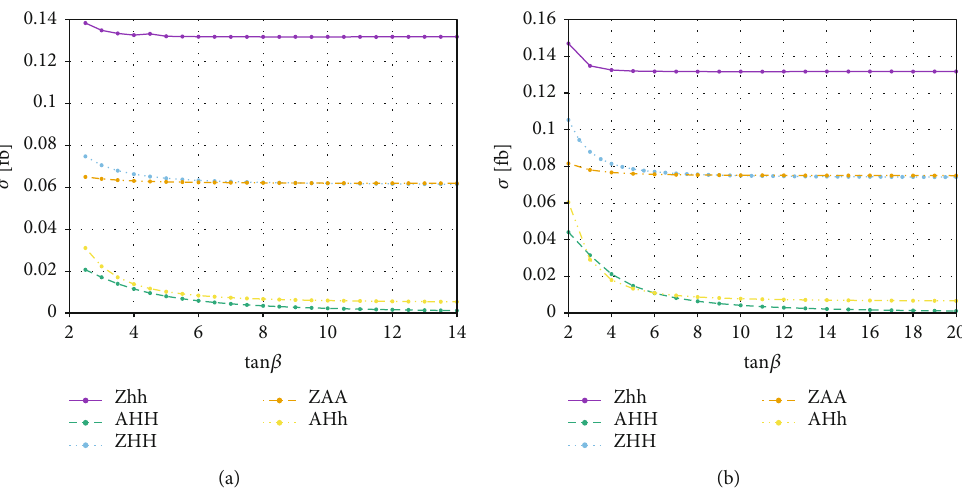
ffiffi p = 1TeV . The values used are m s